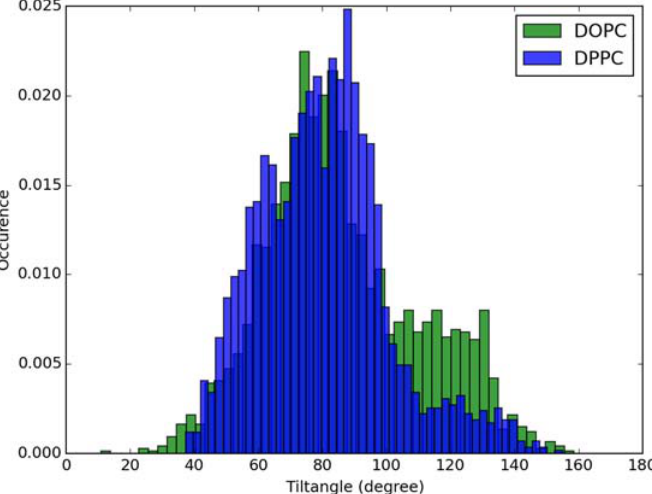
Figure 7. Histogram of tilt angle of Laurdan fluorophore in the S 1 state incorporated into lipid bilayers.